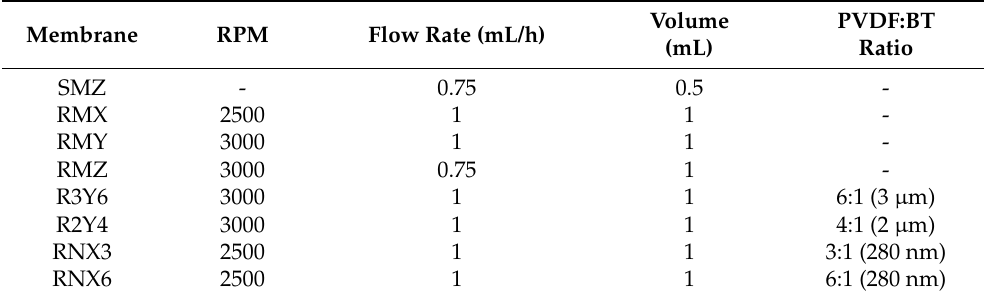
Table 1. Electrospinning parameters used for all membranes characterized; all membranes were produced with 18 kV, 15 cm from tip-to-collector and needle gauge 23.